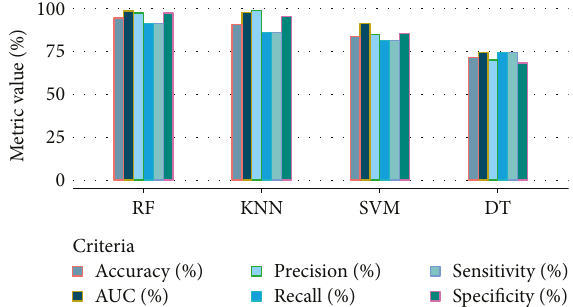
Figure 7: Performance of di ff erent classi fi cation models for MSM dataset.